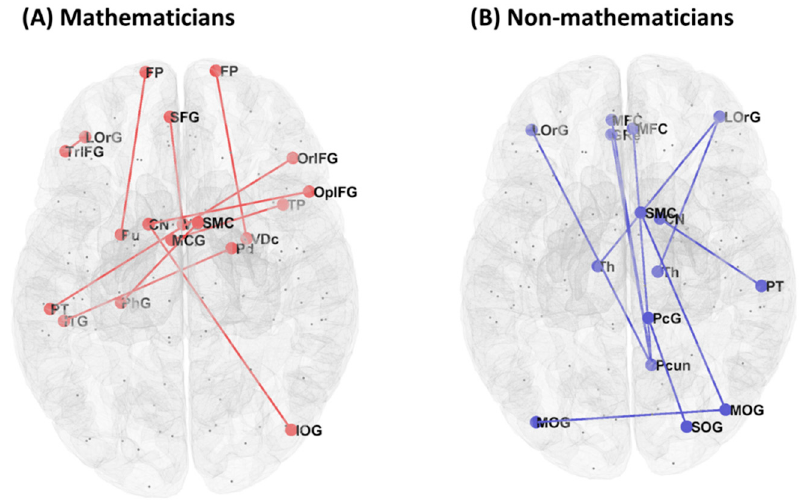
Figure 2. Connectivity of the top-ten ROI pairs selected from Table 2. ROI pairs are denoted with circles connected to one another for ( A ) the mathematician group and ( B ) the non-mathematician group.